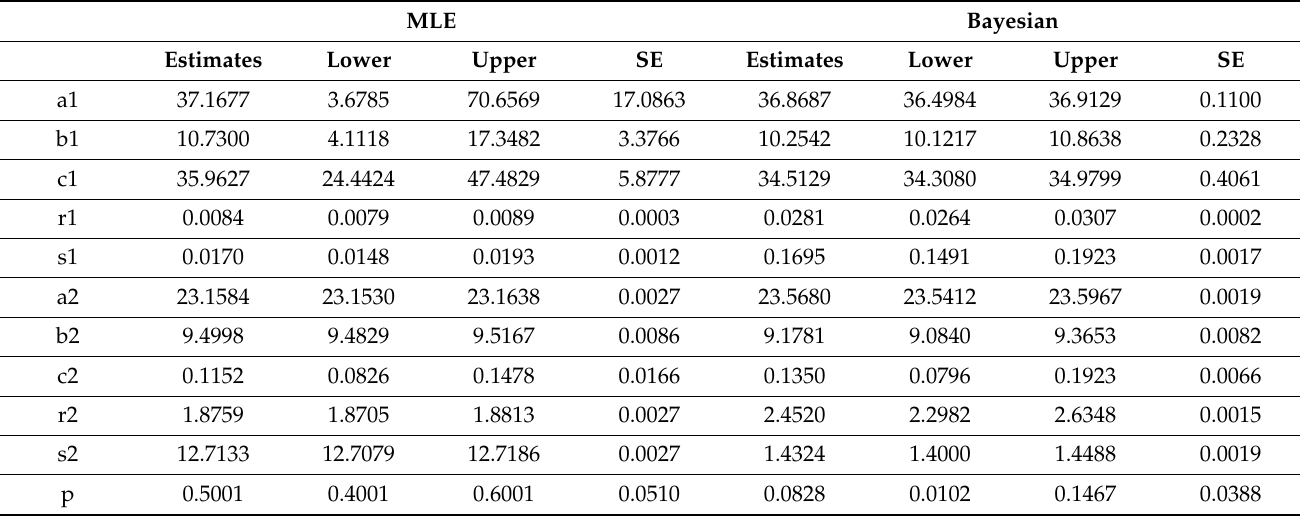
Table 10. MLE and the Bayesian estimates for the fitted MEKGEF model for the Wire data.